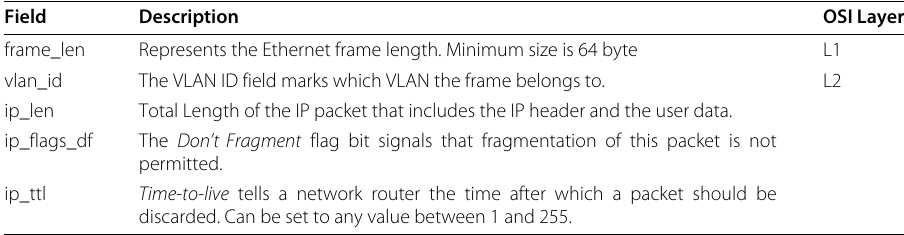
Table 4 Extracted field values from Layers 1 - 3